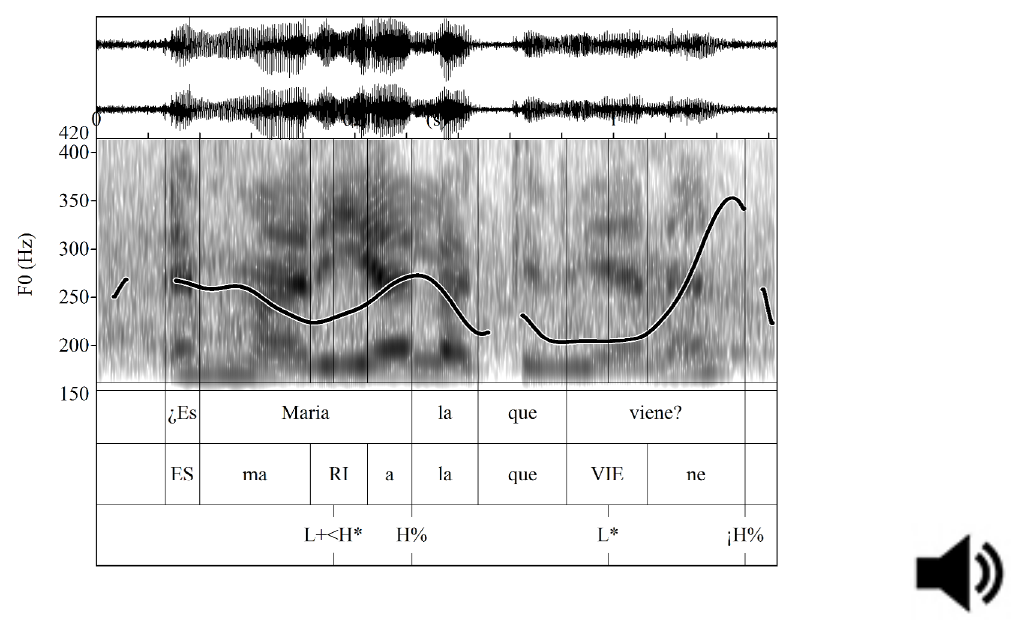
Figure 10 (Participant 6): Waveform and F0 trace for the emphatic yes-no question ¿ Es María la que viene? ‘Is María the one who’s coming?’ produced with two IPs: no tonal event (1 st IP prenuclear accent), L+<H* H% (1 st IP nuclear configuration) and L* ¡H% (2 nd IP nuclear configuration).